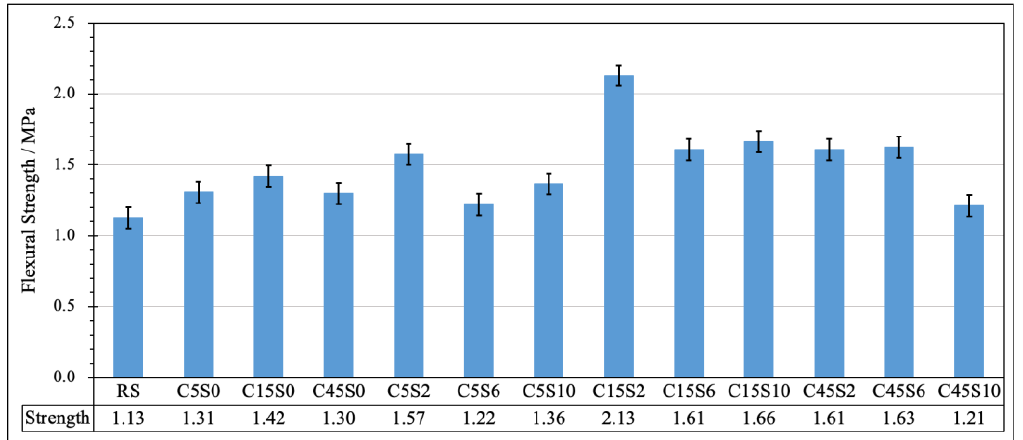
Figure 3. Flexural strength of LWCM.